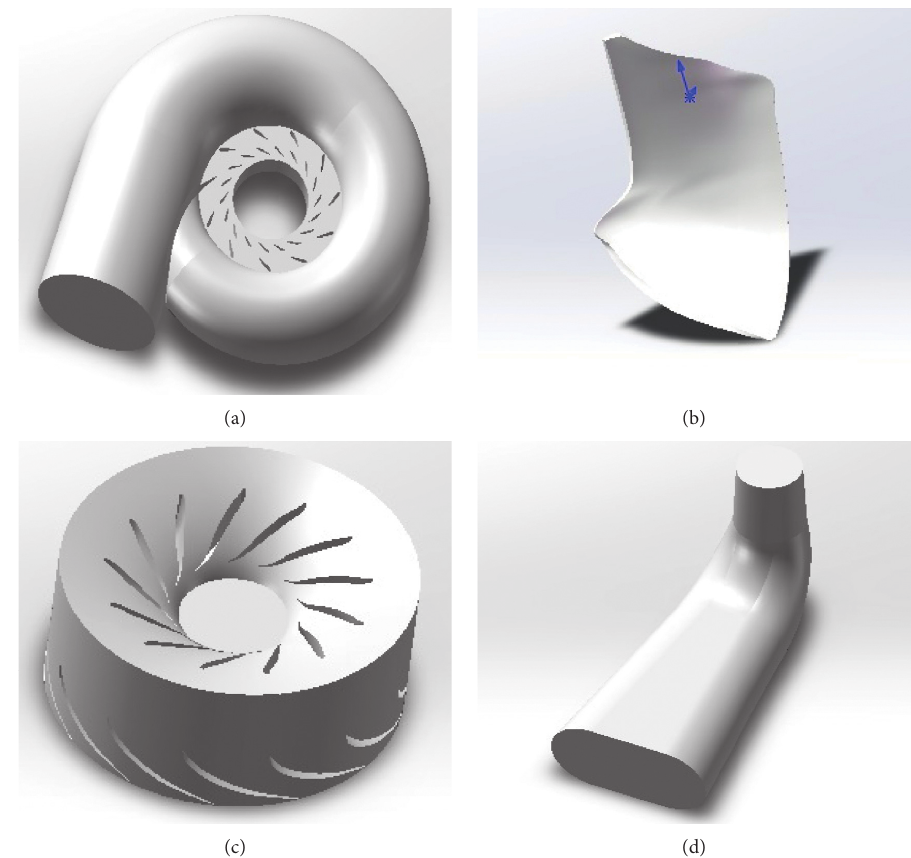
Figure 6: 3D models of characterized components or fluid domains in the Francis turbine. (a) Fluid domain of the volute and guide vanes; (b) blade model; (c) fluid domain of runner; (d) fluid domain model of draft tube.